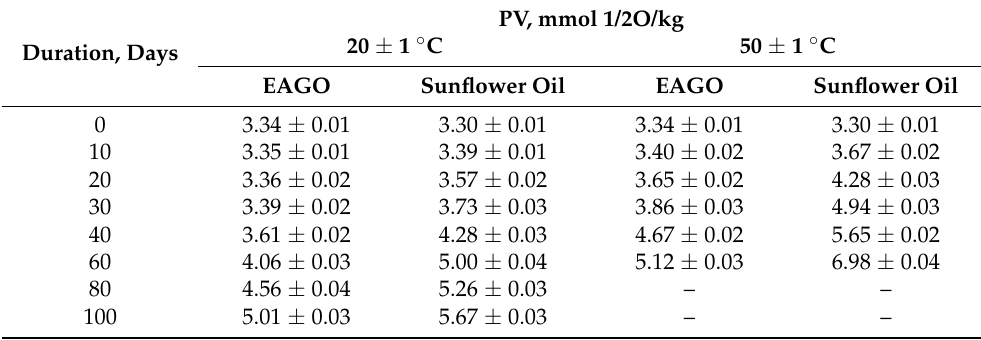
Table 1. Changes in the peroxide value of EAGO and refined sunflower oil during their storage at temperatures of 20 ± 1 ◦ C and 50 ± 1 ◦